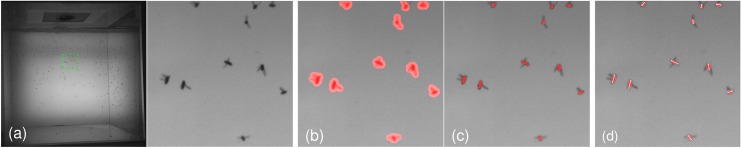
Body detection.(a) The image at the left was filmed by a back-lit camera and the patch marked by the green rectangle was zoomed at the right. (b) The patch was overlaid with red blobs which were detected using background subtraction. (c) The patch ass overlaid with refined blobs in which the pixels of wings were removed. (d) Each refined blob is fitted by an ellipse.